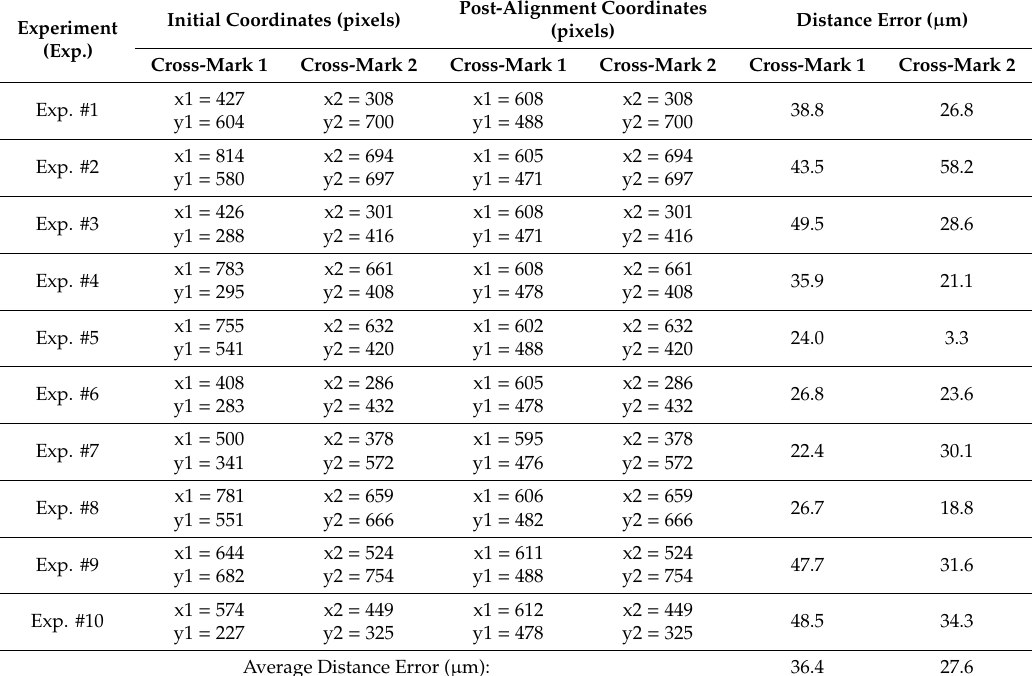
Figure 16. Fields of view of Cameras 1 and 2 showing the PCB cross marks (large white cross marks) and the set points on the fields of view (small red cross marks). Table 6. Experimental PCB alignment results. (Set point coordinates: in FOV1: (x1 = 598, y1 = 482) and in FOV2: (x2 = 480, y2 = 505).).